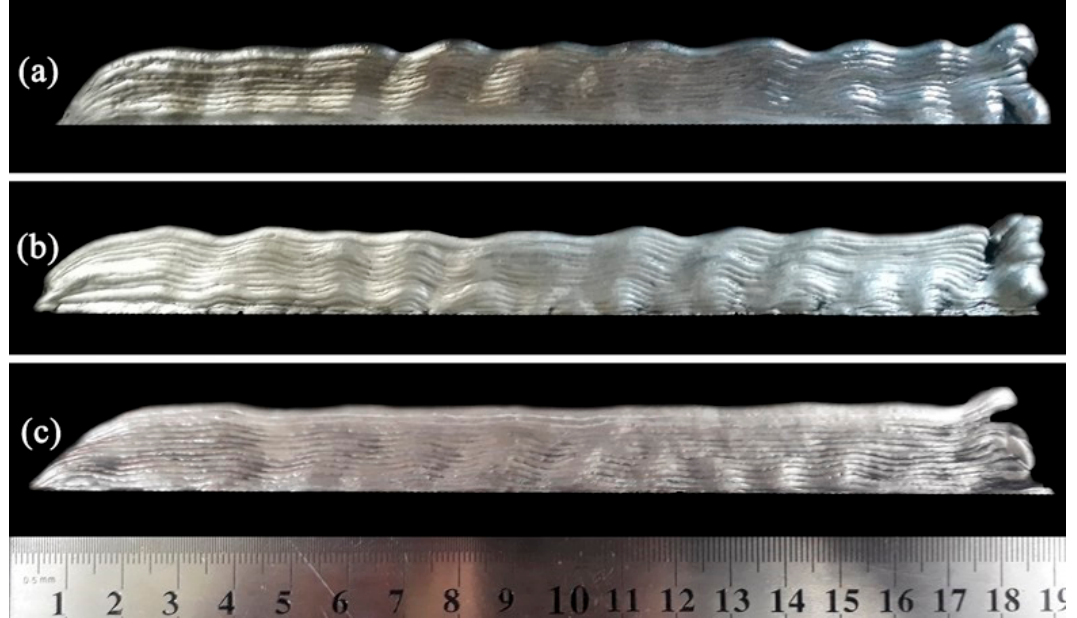
Figure 5. WAAM 14-layer-high walls built with high deposition speeds: ( a ) 185 cm/min; ( b ) 180 cm/min; and ( c ) 175 cm/min (average current of 81 A and voltage of 12.5 V).